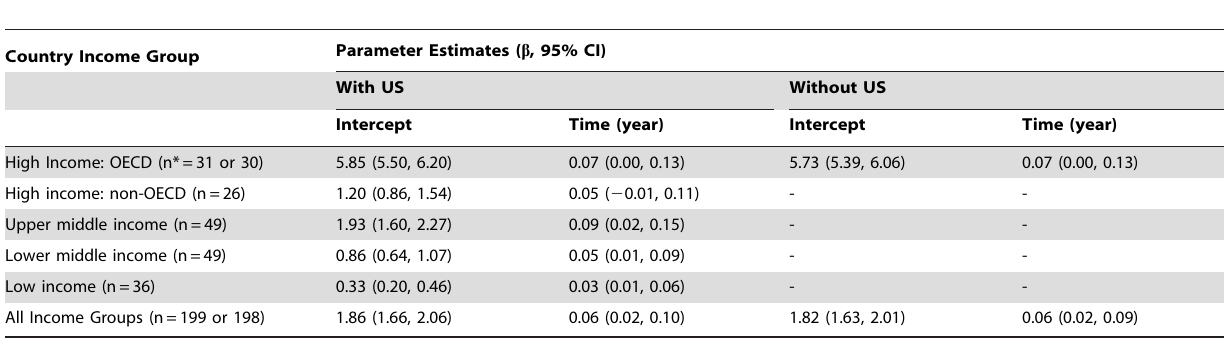
Table 2. Association between year of publication (per year increment) and cardiovascular publication assessed as a log- transformed outcome.